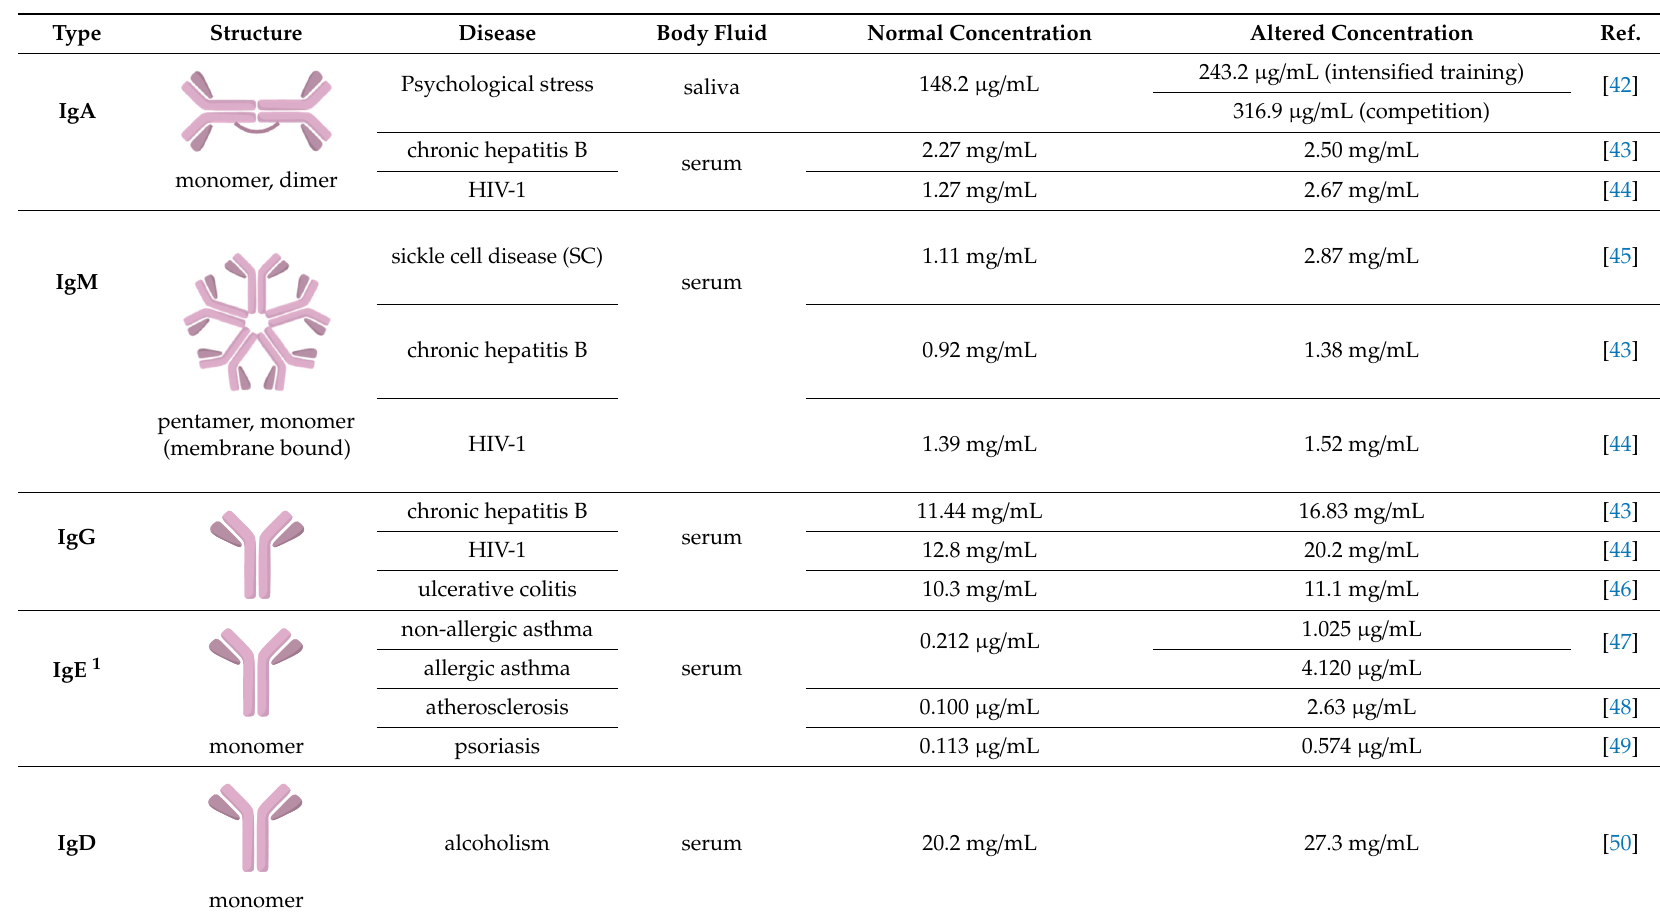
Table 1. Types of immunoglobulins with their structure, some associated diseases and clinically relevant